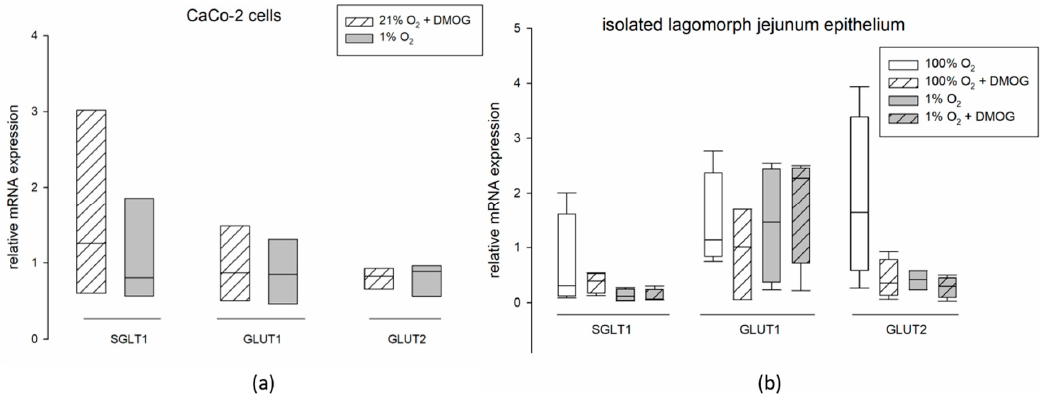
Figure 7. mRNA expression of SGLT1, GLUT1, and GLUT2 in CaCo-2 cells and isolated lagomorph jejunum epithelium. ( a ) Cells were incubated with 3 mM DMOG at 21% O 2 (hatched bars) or under 1% O 2 (grey bars) for 1 h. The mRNA expression was measured relative to the expression levels in the control group (21% O 2 ), whose expression was set to 1. ( b ) Isolated lagomorph jejunum epithelia were incubated with or without 2 mM DMOG under 100% O 2 or 1% O 2 gassing for 1 h. The mRNA expression was measured relative to the expression in native tissue (i.e., not incubated in the Ussing chamber), whose expression was set to 1. There is no significant difference between the different incubation conditions. Boxes show the median, 10th, 25th, 75th, and 90th percentile plus error bars. Paired t-test, N = 3 for CaCo-2 cells and N = 4 for isolated epithelia.